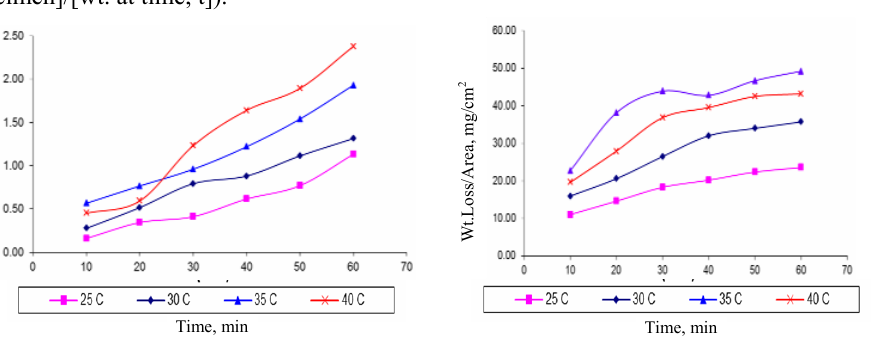
Figure 5. Effect of temperature on corrosion rate in nitric